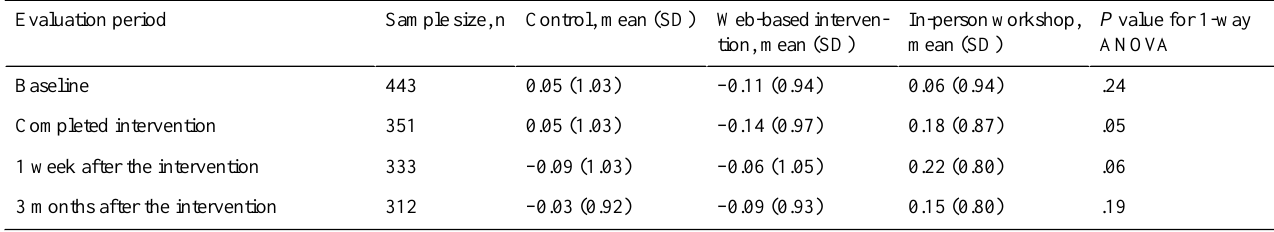
Table 2. Description of TRiPS a scores by treatment conditions and time points.